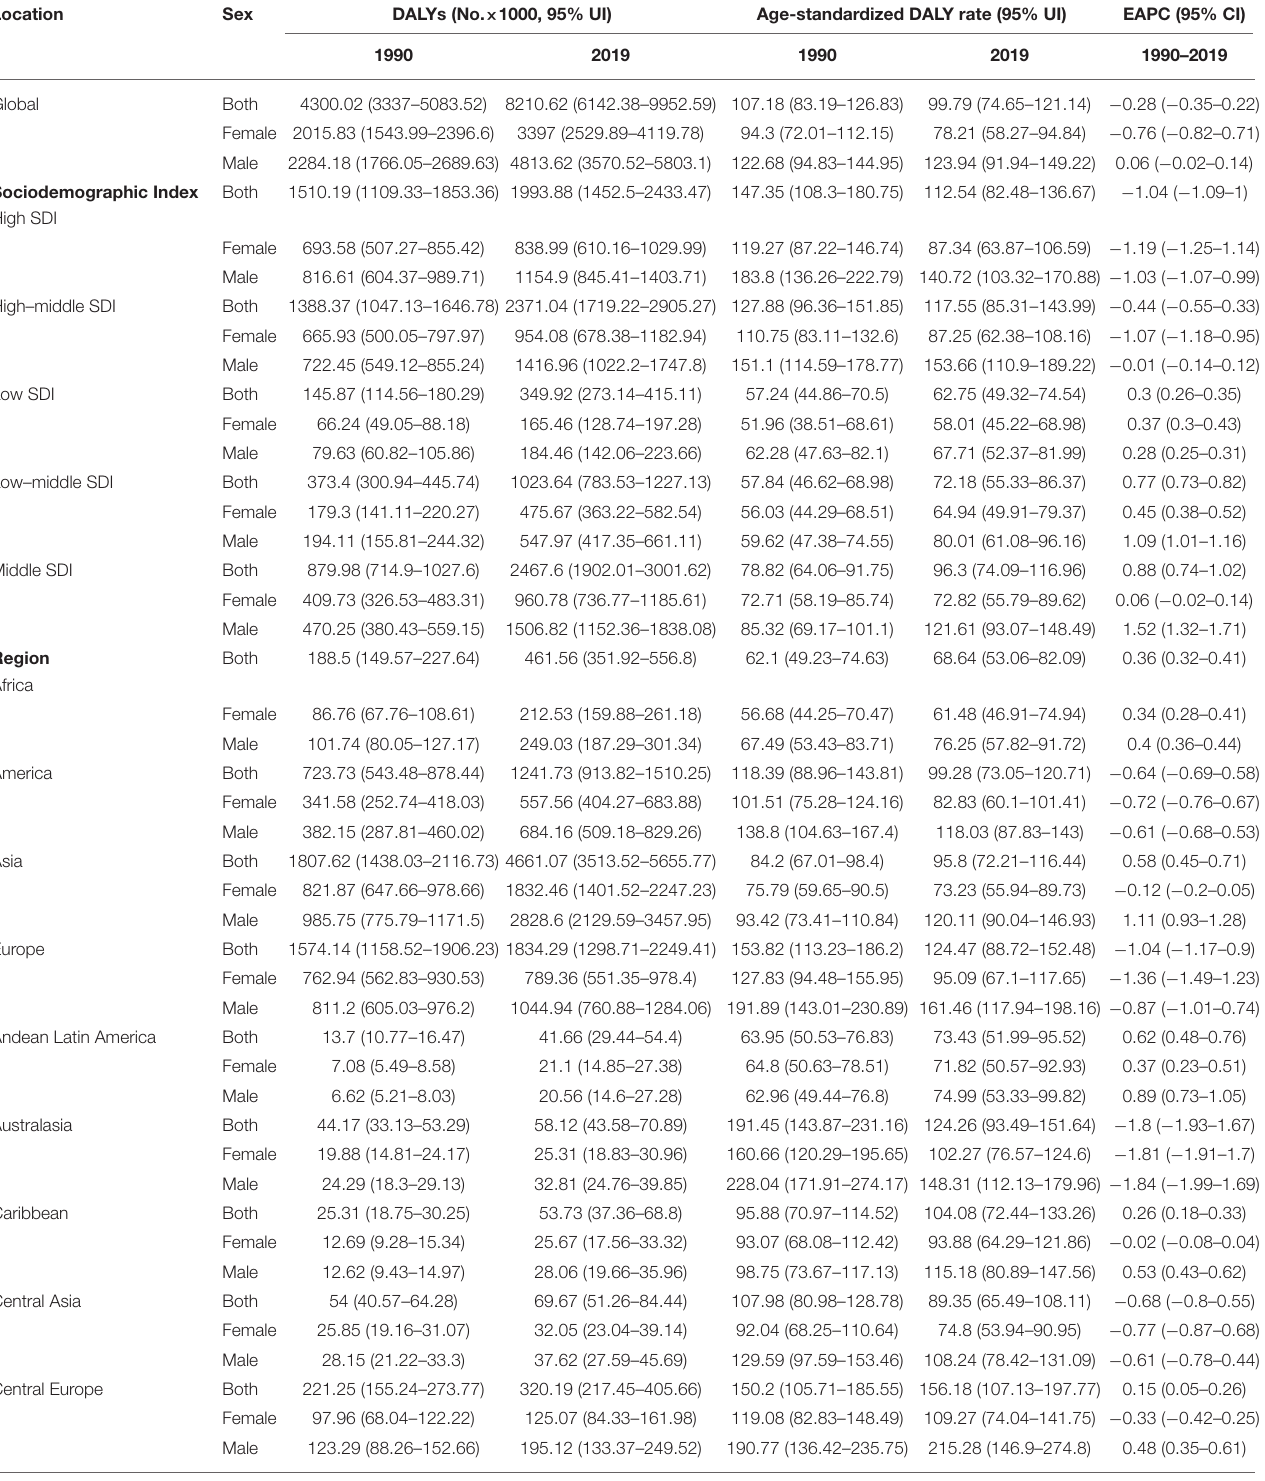
TABLE 3 | DALYs, ASRs, and change trends of colorectal cancer attributable to dietary risks by SDI, regions, and sex.